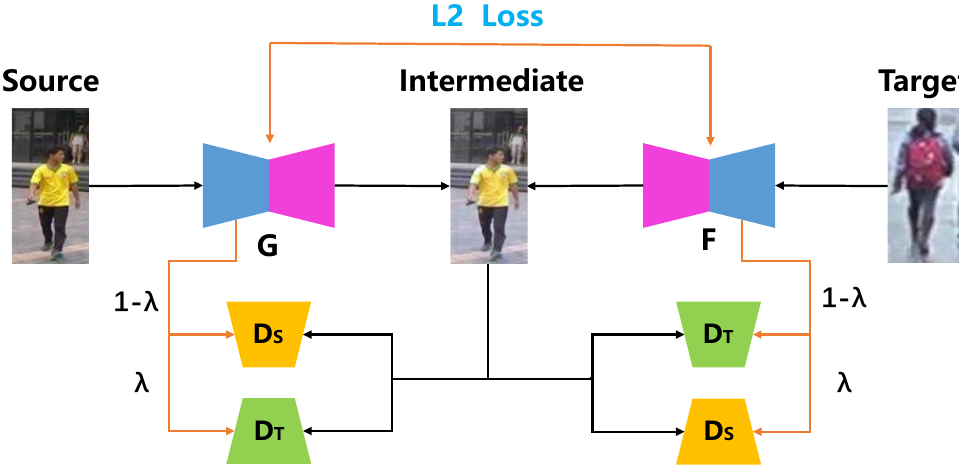
Figure 3. The overview of our proposed GAN model based on SPGAN to generate intermediate domains. λ represents the domainness factor to control the style of the images generated by GAN. The loss function is declared in Equation